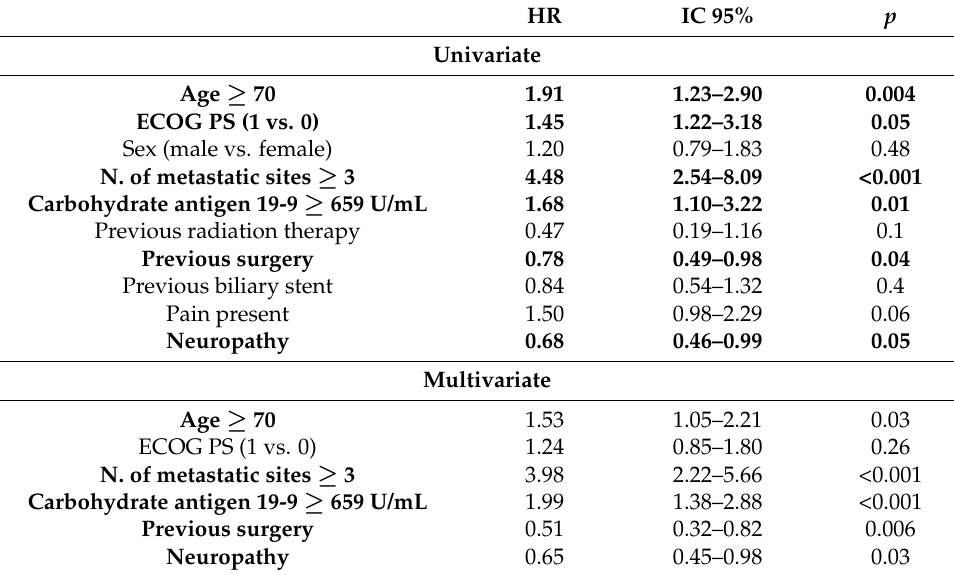
Figure 2. Estimated OS for nab − Gem according to low − grade CIPN presentation. DCR was achieved in 83% of patients with grade 1–2 neuropathy and in 58% of patients without neuropathy ( p = 0.03). The results of the univariate analysis for OS show that age ≥ 70, ECOG-PS 1, number of metastatic sites at baseline ≥ 3, and CA 19–9 ≥ 659 U/mL were found to be negative prognostic factors, whereas previous surgery and grade 1–2 neuropathy (HR: 0.62 95% CI 0.46–0.99, p = 0.05) were found to be significantly positive prognostic factors (Table 3). Table 3. Univariate and multivariate analysis for